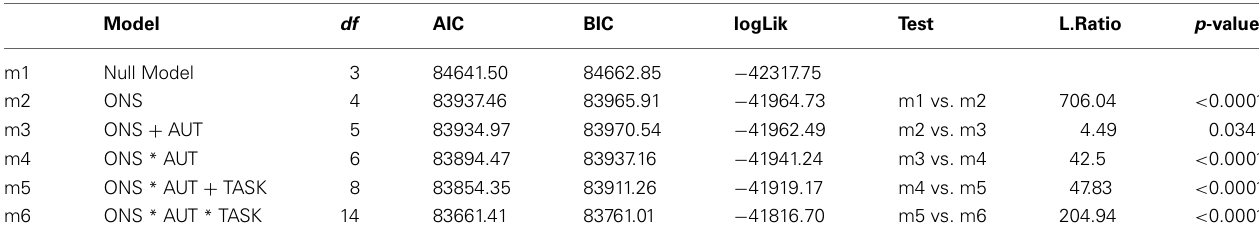
Table 3 | Facial expression condition: best fit mixed-effect models.